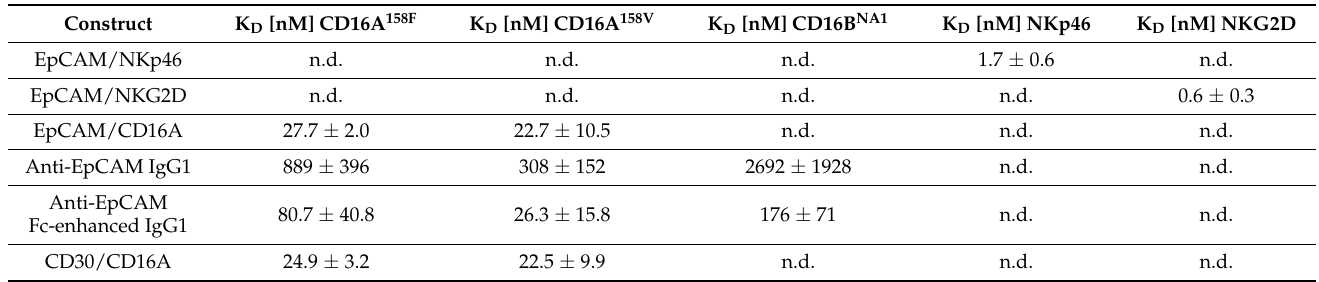
Table 3. Apparent affinities of bispecific ICE ® constructs for CHO cells expressing recombinant human CD16A 158F , CD16A 158V , CD16B NA1 , NKp46, and